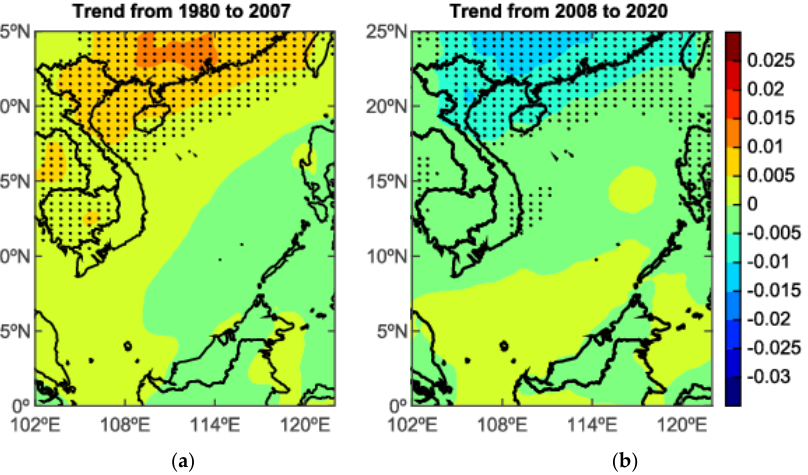
Figure 9. Variation trend of MERRA − 2 AOD over the SCS during the period ( a ) 1980 − 2007 and ( b ) 2008 − 2020 (the small black dot represents p < 0.05). ( b ) 2008 − 2020 (the small black dot represents p <